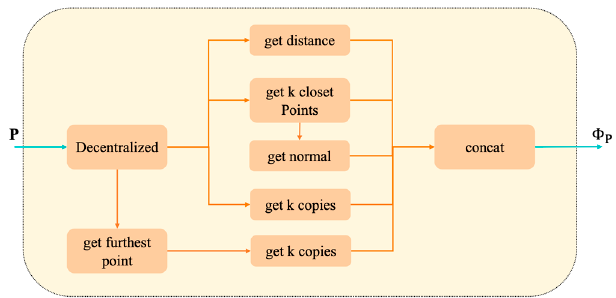
Figure 16. Point structure extractor of the DeepMerge.